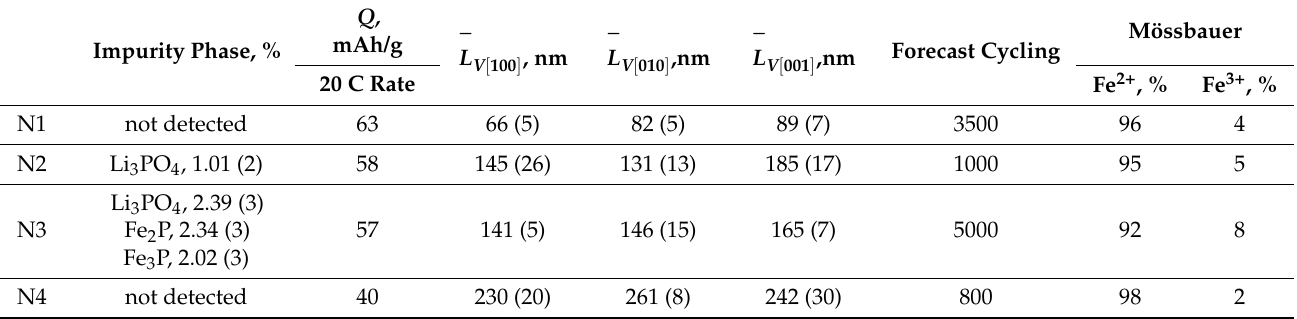
Table 2. SXRD composition of impurity crystallites in powders [96], XRD anisotropic sizes of LiFePO 4 crystallites L V [ hkl ] averaged over the length of their columns [97] (from [98]). MS fractions of Fe 2+ and Fe 3+ compounds (description below). Forecast cycling of a test cathode after 100 times cycling at 1 C rate. The errors of L V [ hkl ] reported in parentheses characterize the